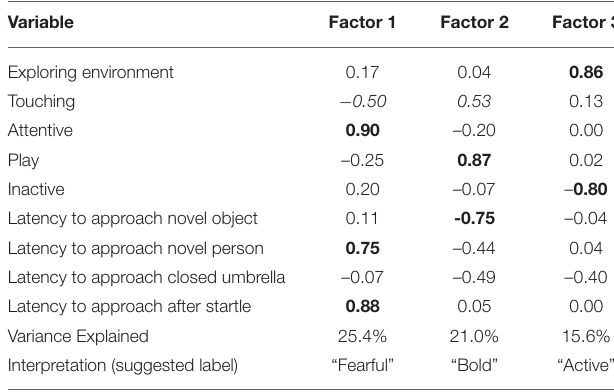
TABLE 2 | Time spent performing each behavior measured in the traditional personality tests (novel person, novel object and startle test). Variable